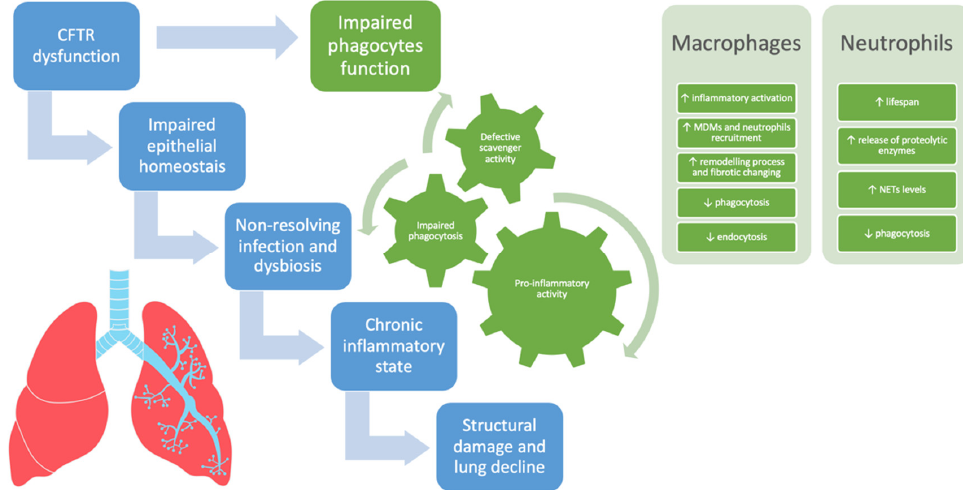
Figure 1. The involvement of phagocytes and neutrophils in driving lung disease progression in cystic fibrosis. CFTR = cystic fibrosis transmembrane conductance regulator, MDMs = monocyte-derived macrophages, NETs = neutrophil extracellular traps.